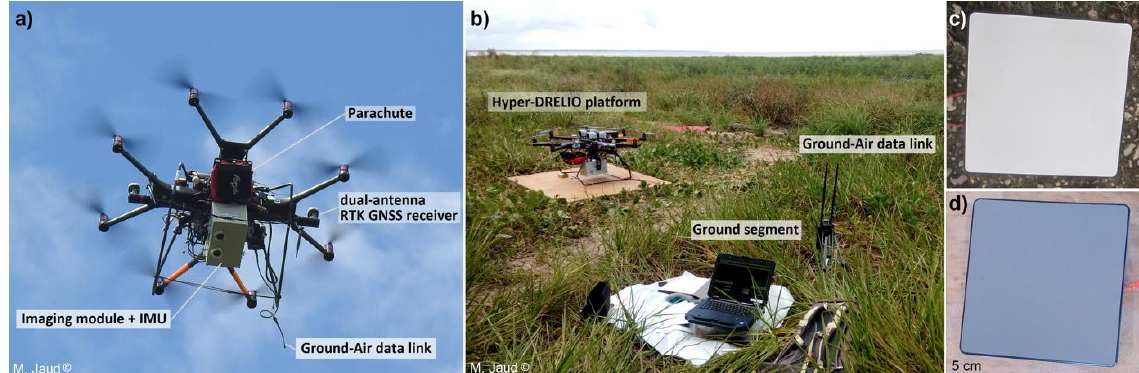
Figure 2. ( a , b ) Hyper-DRELIO (Hyperspectral DRone for Environmental and LIttoral Observations) platform, unmanned aerial vehicle (UAV) for hyperspectral imagery. IMU: inertial motion unit; RTK GNSS: real time kinematic global navigation satellite system. ( c ) White Spectralon panel (reflectivity: 99%). ( d ) Grey Spectralon panel (reflectivity: 20%).